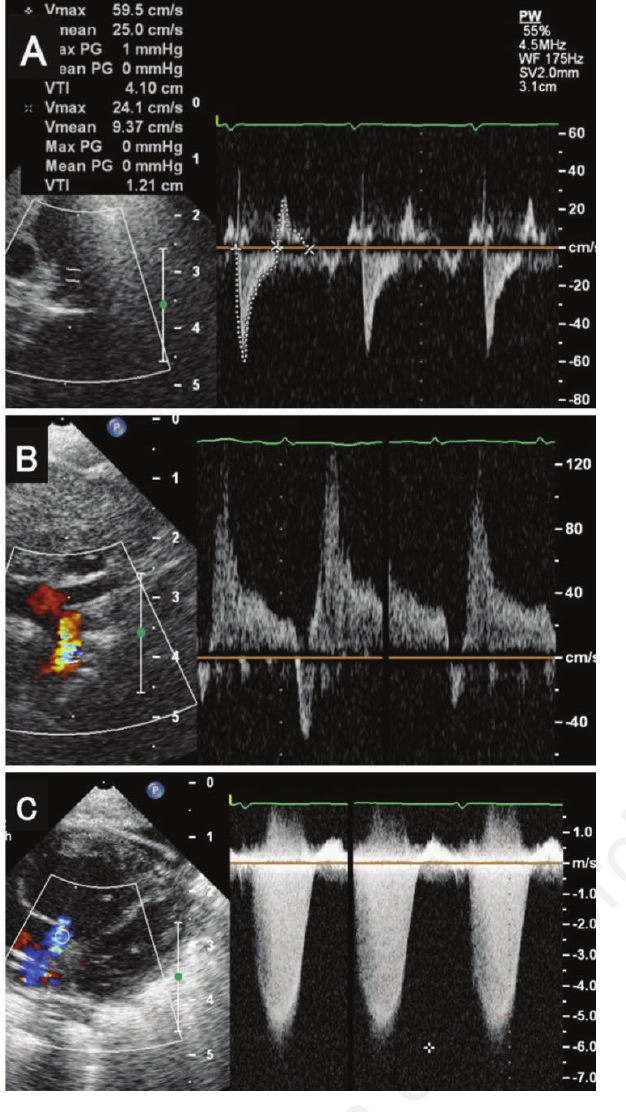
Figure 1. Echocardiographic findings. A) Pulmonary flow, a reverse flow was detected at end-diastole; B) Aortic isthmus flow, a reverse flow through the dustus arteriosus from early systole to end-diastole; C) remarkable tricuspid valve regurgitation at 3 days old.